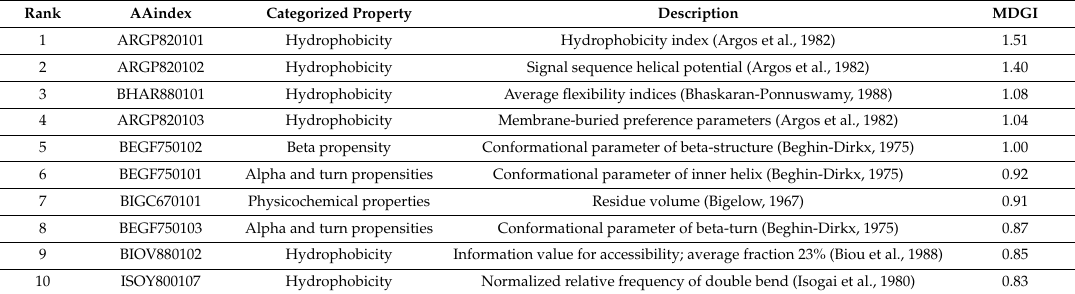
Ten top-ranked physiocochemical properties from the AAindex having the highest MDGI